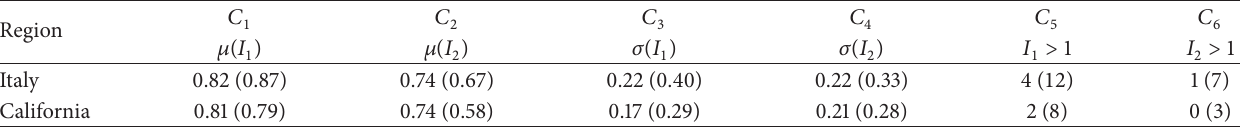
Table 4: Evaluation of the smart passive strategy according to the six criteria (the values between brackets are the indices calculated for the pure passive control case).